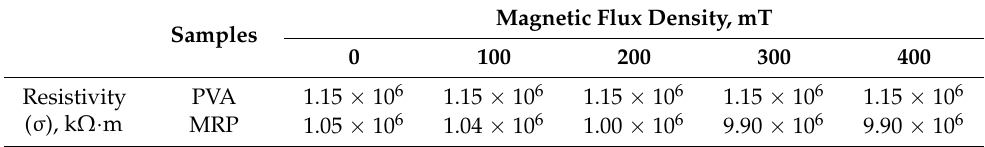
Table 3. The resistivity values of PVA and MRP under different magnetic flux